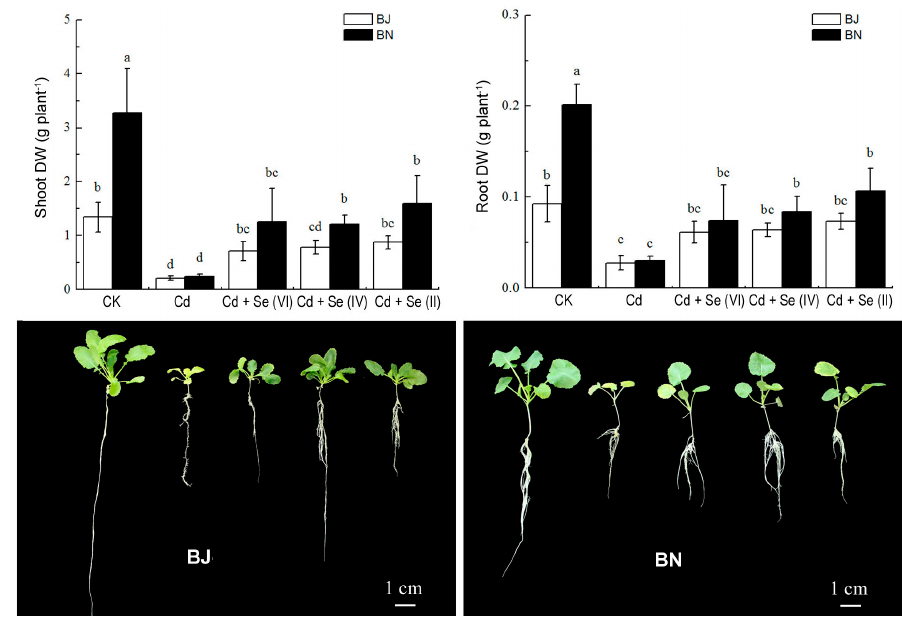
Figure 1. Dry mass variation in shoot and root of Brassica seedlings were exposed to five treatments (1) control, (2) 50 μ mol/L Cadmium (Cd), (3) 3 μ mol/L Na 2 SeO 4 +50 μ mol/L Cd, (4) 3 μ mol/L Na 2 SeO 3